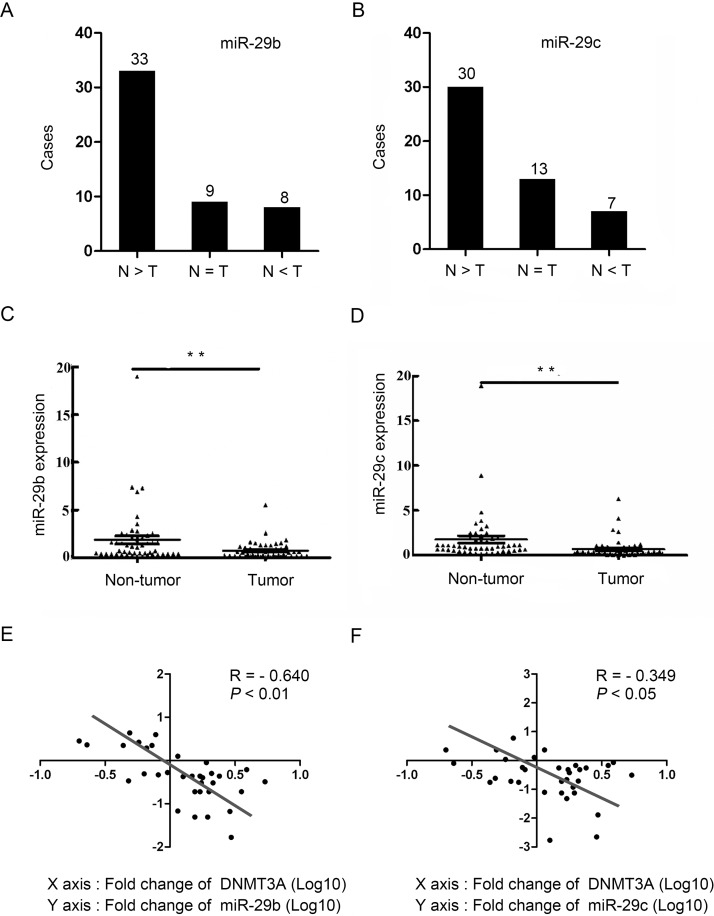
Decreased miR-29b/c in GC tissue samples.(A and B) qRT-PCR analysis showing miR-29b (A) or miR-29c (B) in 50 GC tissues (T) and paired non-tumor tissues (N). Clinical samples were divided into three groups based on miRNA relative expression scores greater or less than two fold: N>T, N = T and N<T. The case number is shown in every group. (C and D) Scatter plots of miR-29b (C) or miR-29c (D) fold changes in GC and their paired non-tumor tissues. In both panels, the horizontal lines represent the median and the vertical bars representing the range of the data (**P<0.01). (E and F) Correlation between DNMT3A and miR-29b (E) or miR-29c (F) expression in 33 clinical samples, with linear regression lines and Pearson correlation significance (miR-29b: R = -0.640; **P<0.01; miR-29c: R = -0.349; *P<0.05; Pearson χ2 test).